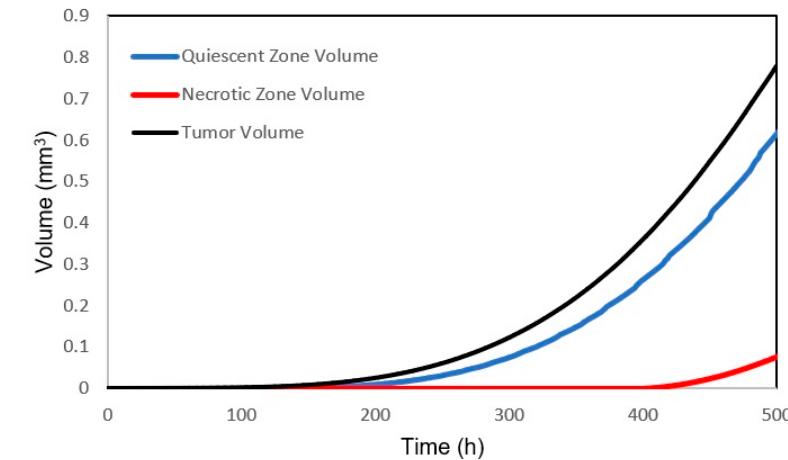
Figure 5. ( a ) Glucose; ( b ) Oxygen concentration during the growth of a tumor (concentrations of glucose and oxygen in the culture medium are constant versus time and they are respectively 0.8 mM and 0.28 mM). The initial radius of the tumor is 24.3 μ m. ( c ) Volume distributions of the different regions of the tumor .